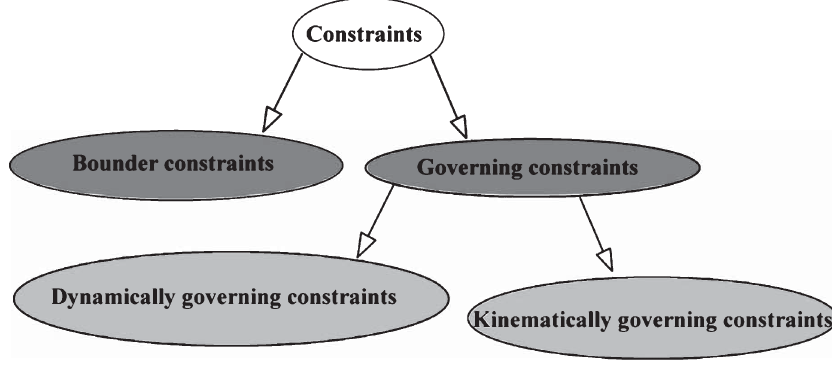
Fig. 1. Constraints classification.